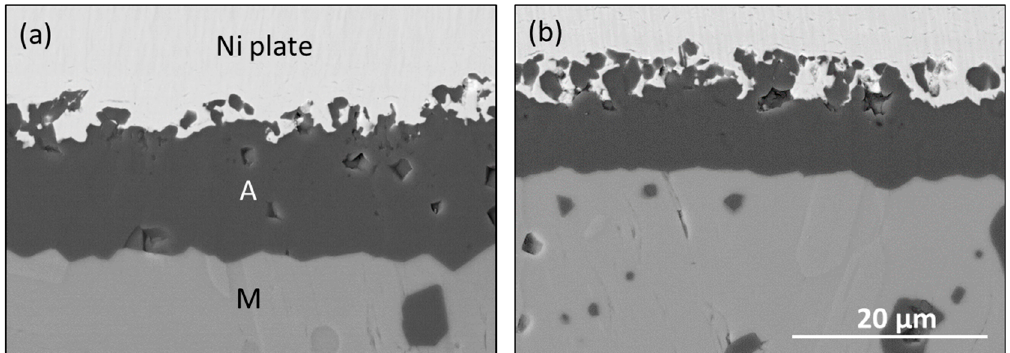
Figure 7. SEM/BSE surface microstructures of scales formed on Ti 2 AlC at 1300 °C in Mach 0.3 high velocity burner rig (500 h at 1300 °C) Uncoated backside at sample ( a ) top, ( b ) hot center, ( c ) grip end. T (Ti-rich transient scale); A (Al 2 O 3 ); P (etched platelets) [15].